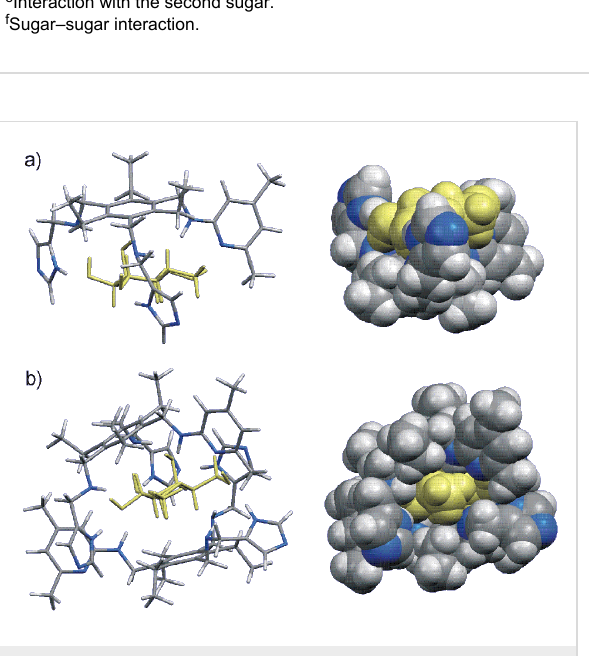
Figure 7: Energy-minimized structure of the 1:1 a) and 2:1 complex b) formed between receptor 4 and β-galactoside 8b (different representa- tions). MacroModel V.8.5, OPLS-AA force field, MCMM, 50000 steps. Color code: receptor C, grey; receptor N, blue; sugar molecule, yellow.